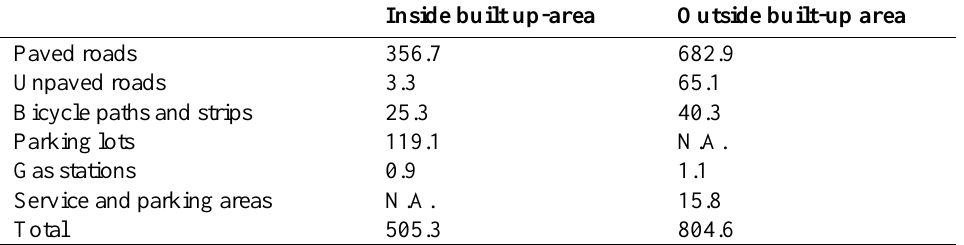
Table 3. Land use by road infrastructure in the Netherlands (in km 2 ) Inside built up-area Outside built-up area Paved roads